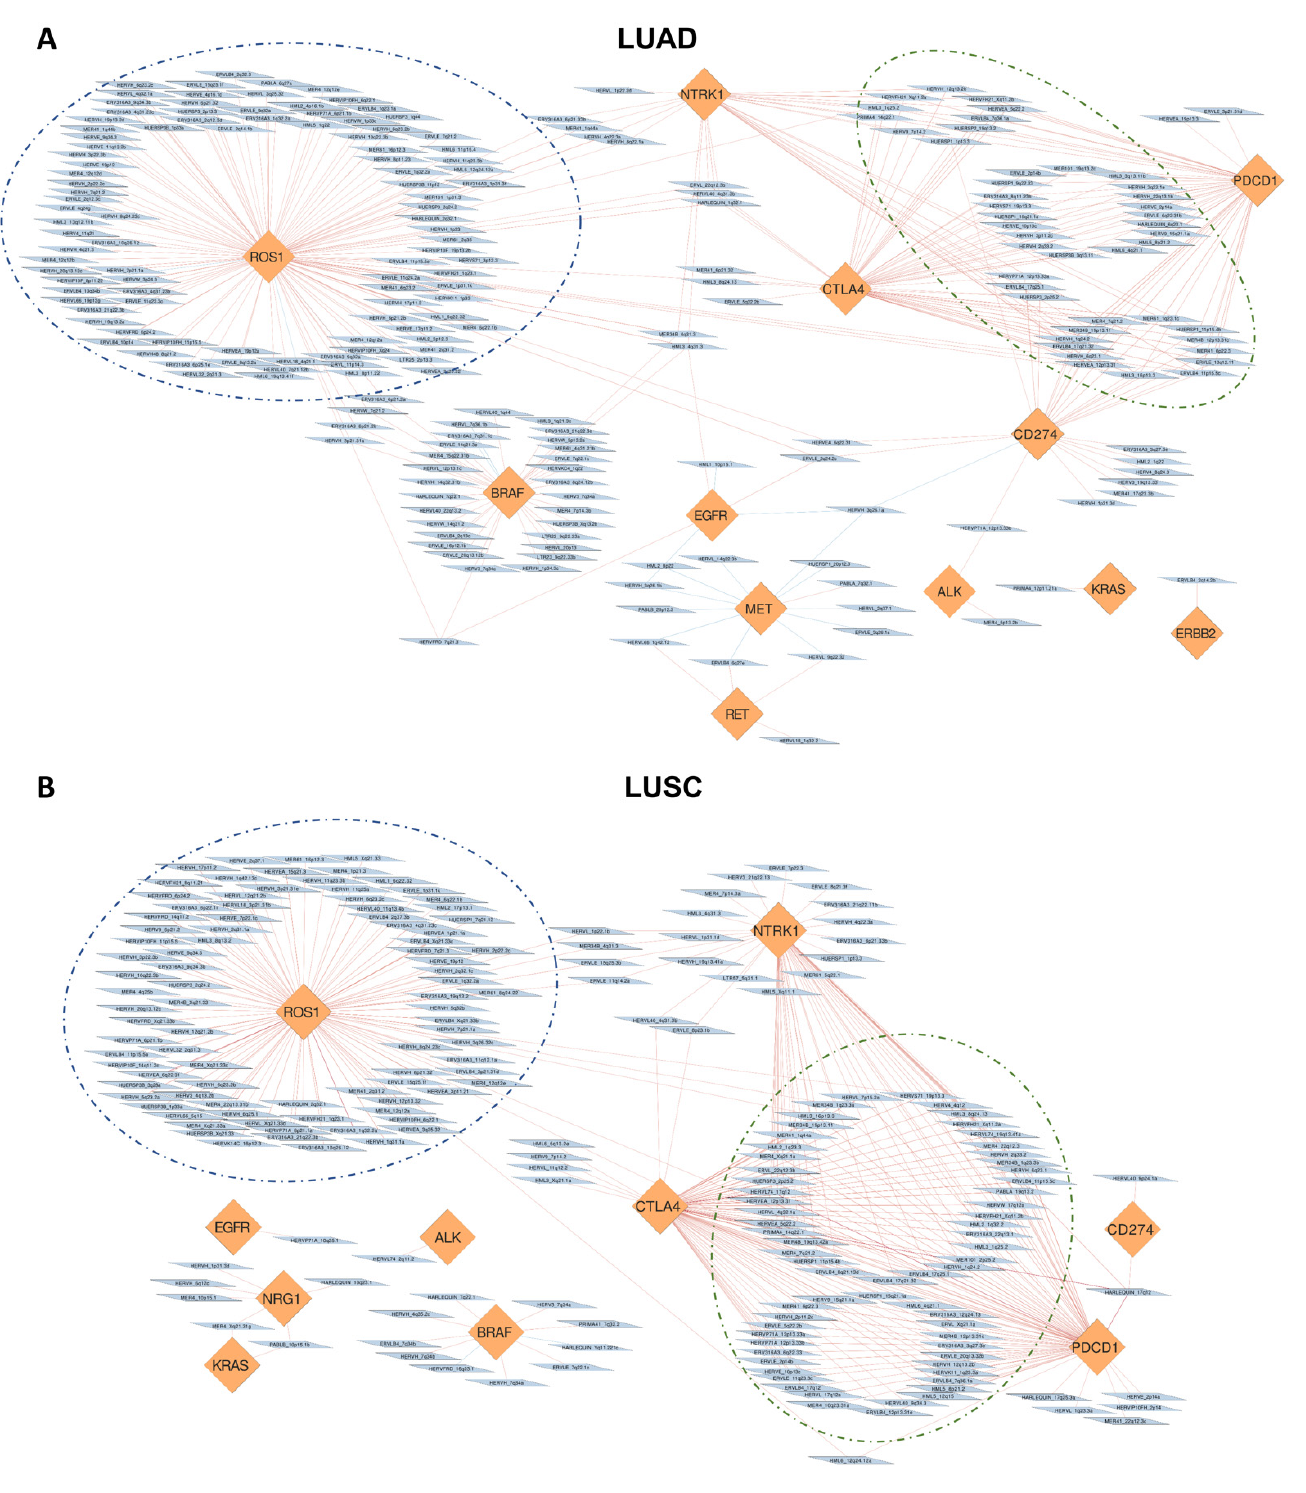
Figure 5. Correlation networks showing the connections between HERVs and a list of selected on- cogenes and adaptive immunity regulators in TCGA − LUSC ( A ) and TCGA − LUSC ( B ). In the net- works, the blue nodes represent the HERVs and the orange nodes represent the genes.